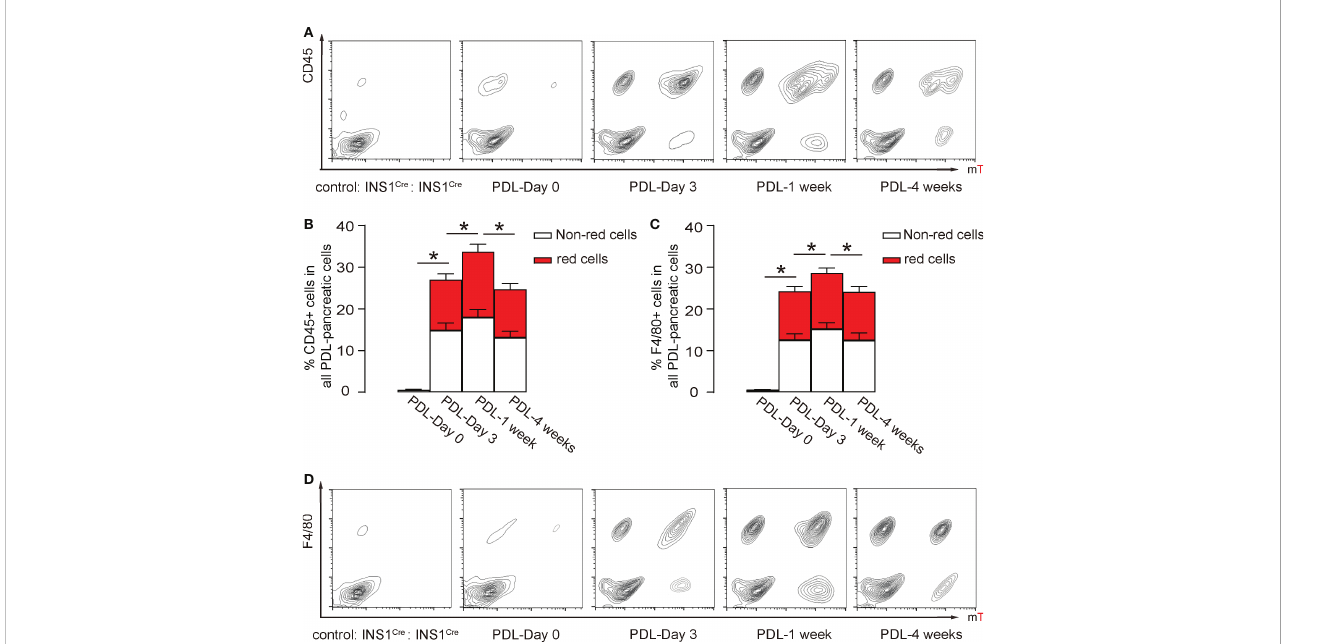
FIGURE 5 In fl ammatory cells in the PDL pancreas are mainly recruited from the circulation. (A, B) Flow cytometry analysis of red fl uorescent and CD45+ cells in the digested pancreas, shown by representative fl ow charts (A) and by quanti fi cation of (red) CD45+ cells in all PDL-pancreatic cells (B) . (C, D) Flow cytometry analysis of red fl uorescent and F4/80+ cells in the digested pancreas, shown by quanti fi cation of (red) F4/80+ cells in all PDL-pancreatic cells (C) and by representative fl ow charts (D) . *p<0.05. N=5